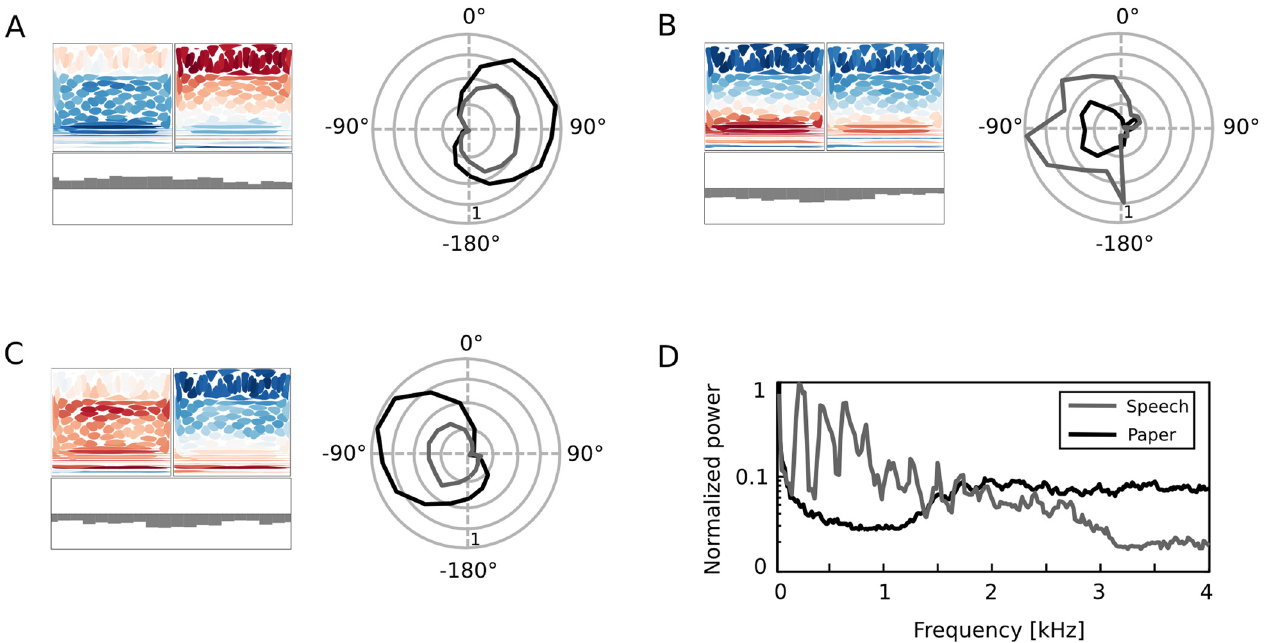
Fig 10. Comodulation of unit responses by sound position and identity. A)-C) Three representative second layer basis functions plotted with spatial tuning curves obtained using two different sounds — female speech (gray) and paper noise (black). D) Frequency spectra of both test